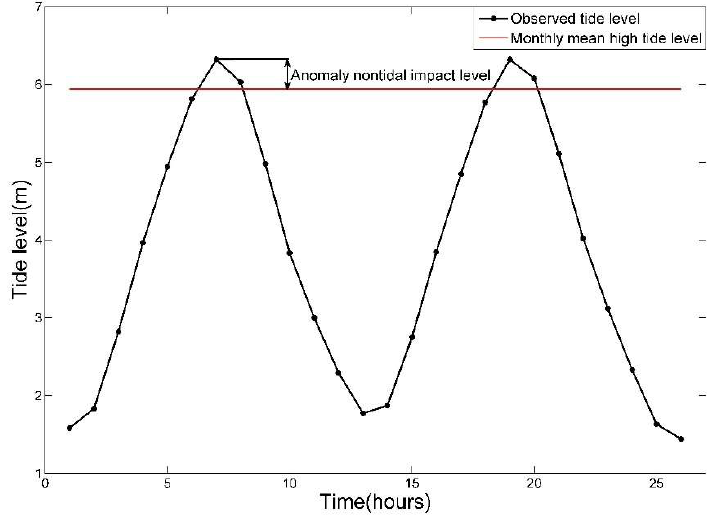
Figure 1. The definition of storm surge caused anomaly nontidal impact level (on the TC landfall day)